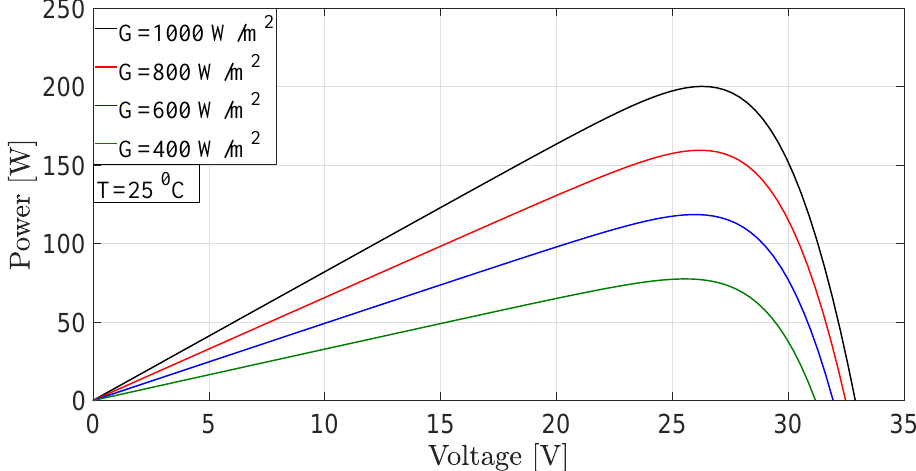
Figure 1. P-V characteristics of the PV source under different radiation